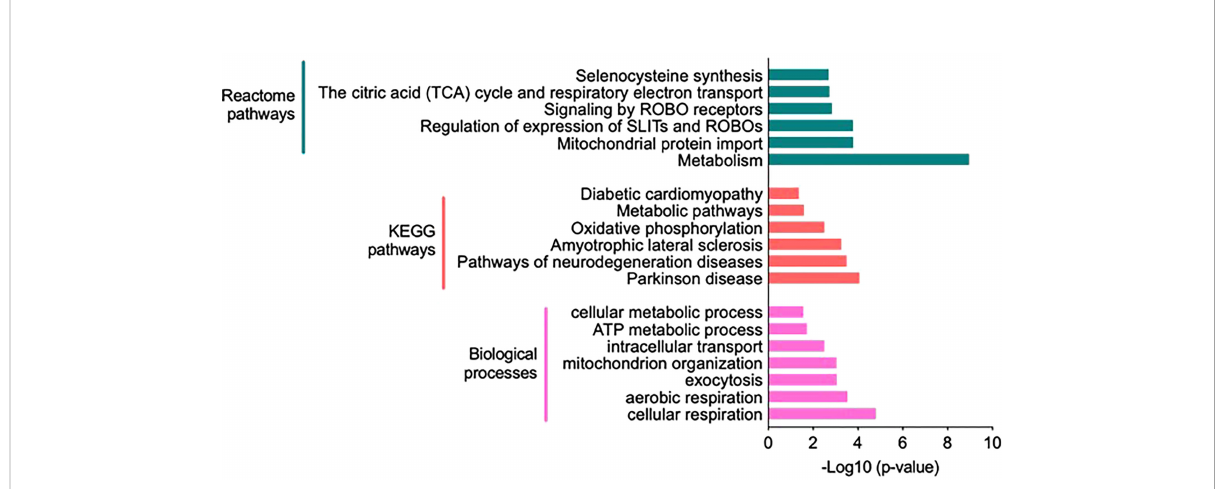
FIGURE 4 Functional annotation and classi fi cation by enrichment analysis of proteins uniquely present in the high insulin sensitivity group. Top enriched terms and their distribution categorized into biological processes, Kyoto Encyclopedia of Genes and Genomes pathways, and Reactome pathways (Supplementary Table